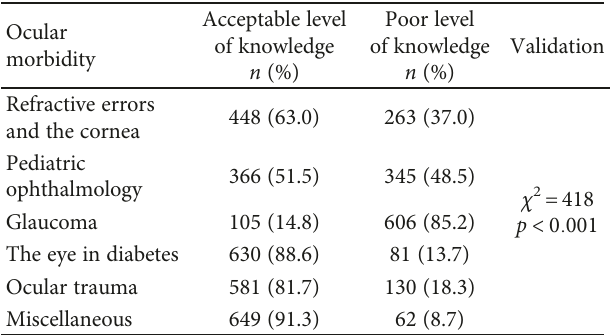
Table 3: Levels of ocular morbidity-related knowledge among Saudi adults in Riyadh city